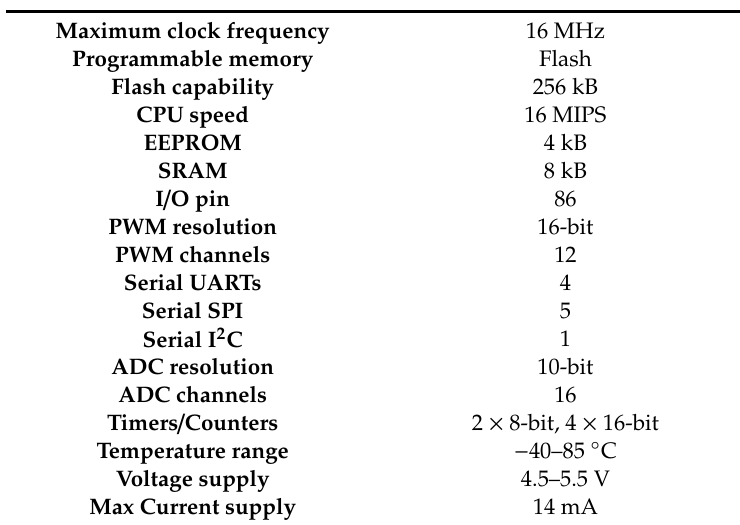
Table 2. Specifications of the Atmel ATmega2560-16AU microcontroller.